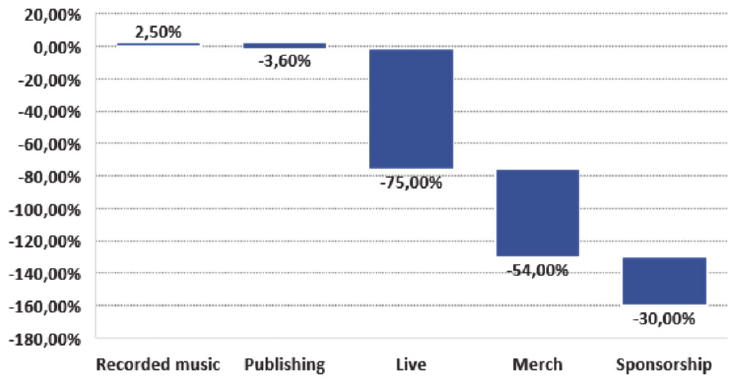
<Figure 1> Projections For Music Market in 2020 compared to